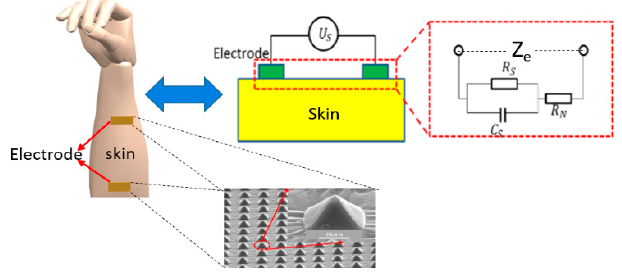
Figure 1. Skin–electrode contact impedance equivalent circuit diagram.